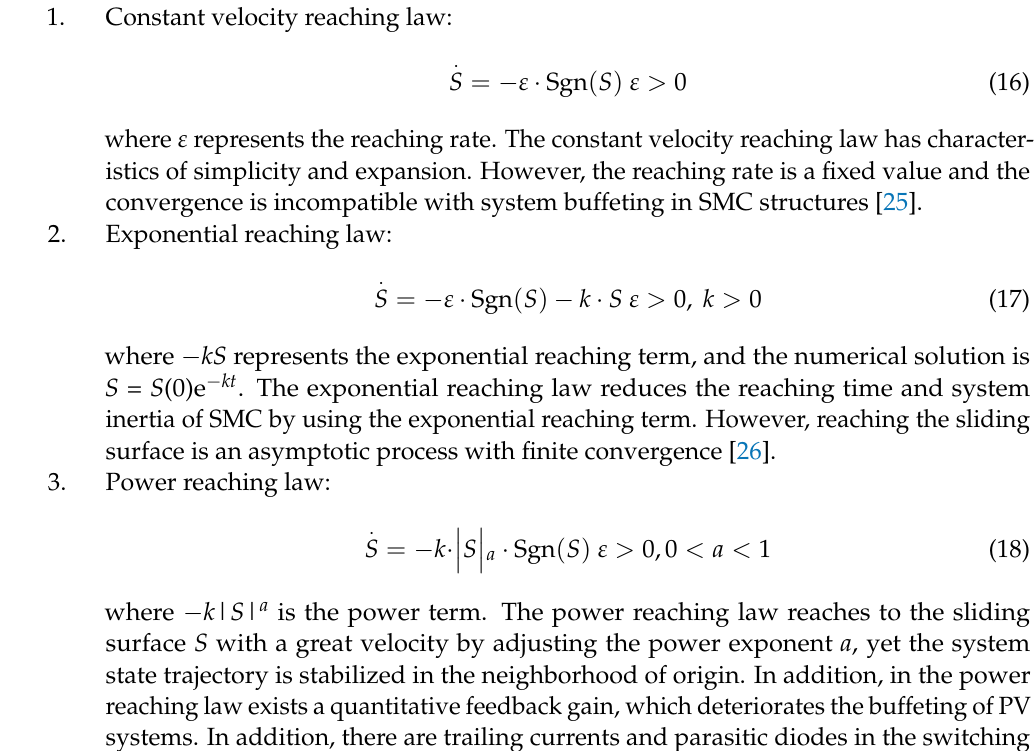
is shown in Equation